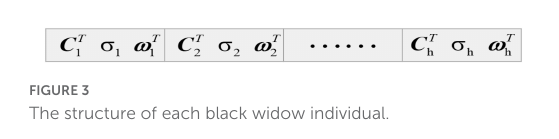
algorithm and RBFNN are connected by candidate solution vectors of the IBWO algorithm, which is shown in Figure 3 .